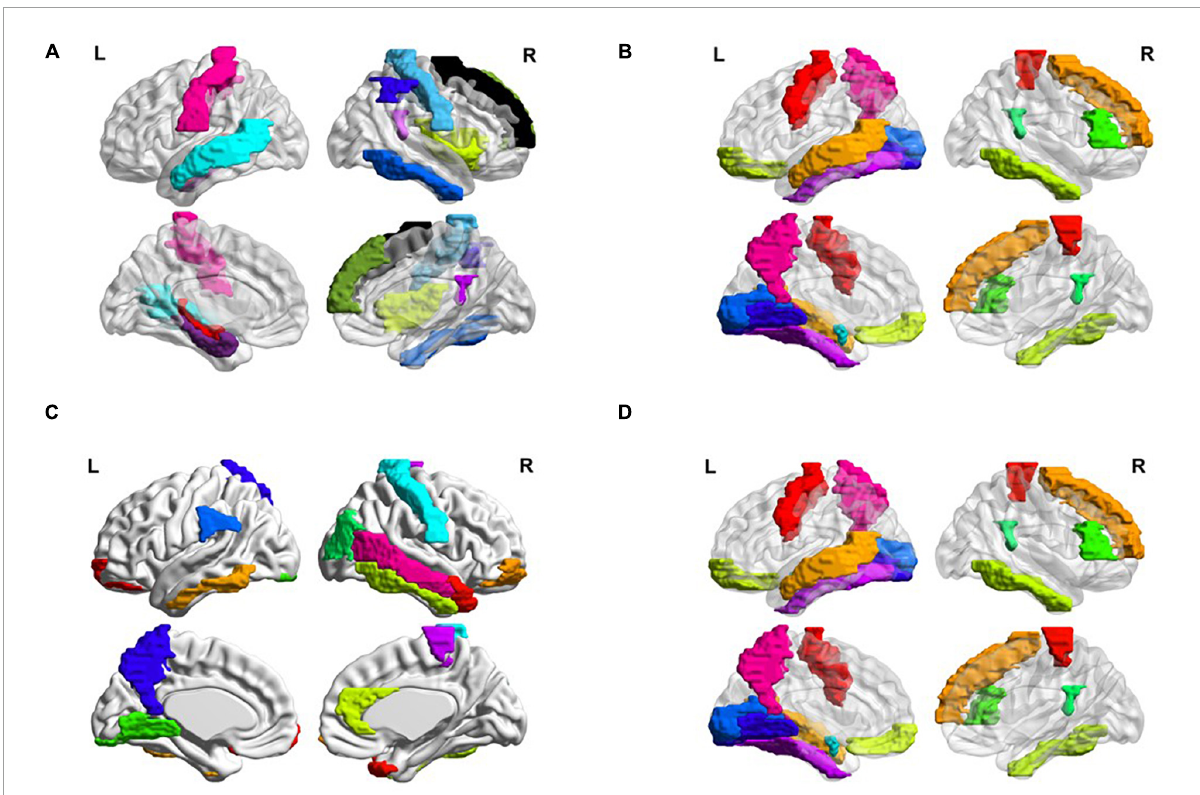
FIGURE6 Most discriminative regions of interests (ROIs) identified by our proposed MBFN method in four tasks of (A) eMCI vs. NC, (B) lMCI vs. NC, (C) AD vs. NC, and (D) eMCI vs.